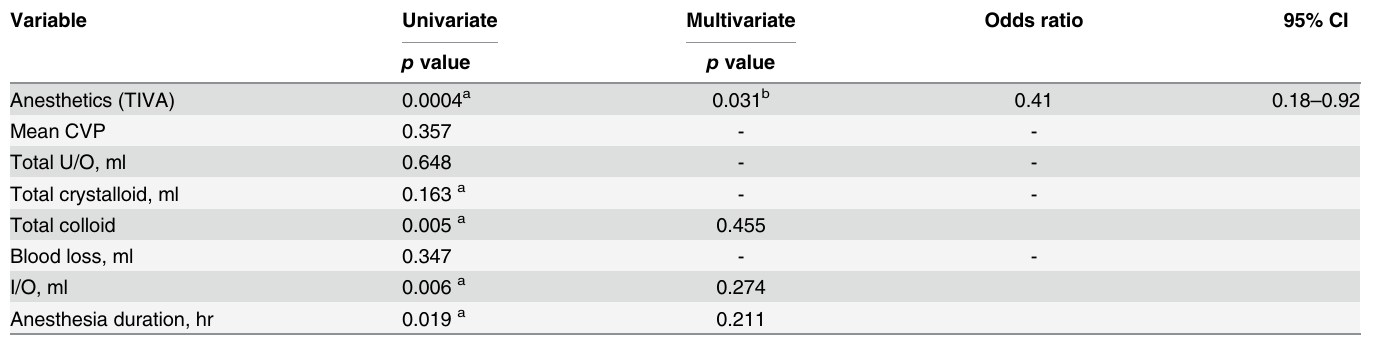
Table 4. Regression of pulmonary